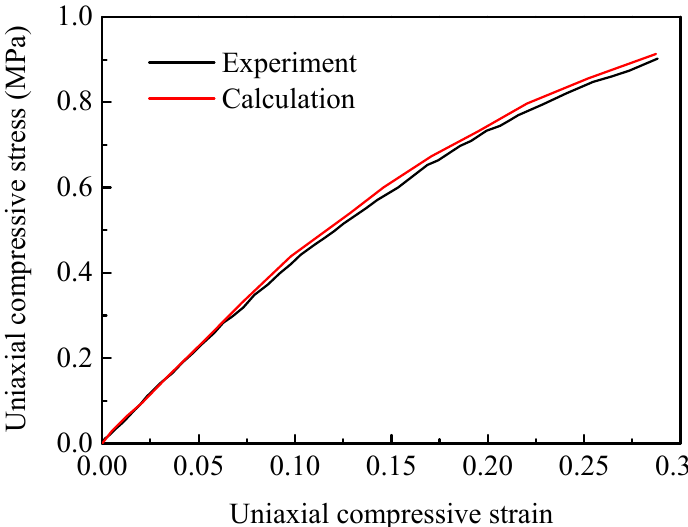
Figure 5. Calculated and measured stress-strain curves of Estane 5703 at compressive strain rate of 10 − 3 s − 1 . Experiment by Cady et al. [30].